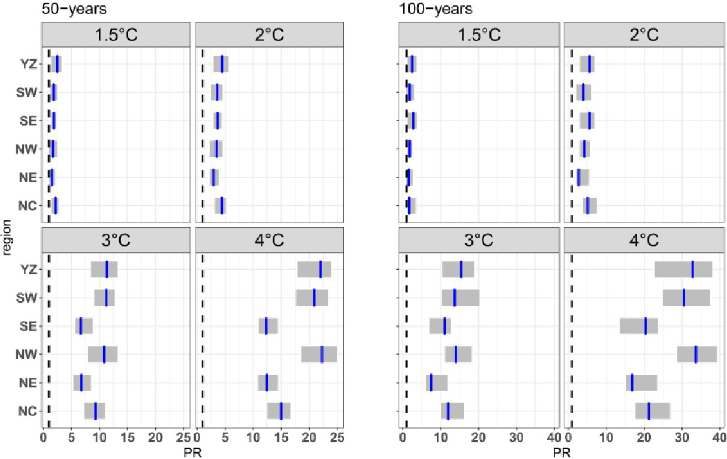
Fig 7. PR of 50-year and 100-year extreme precipitation events occuring under four warming levels across China and its six subregions.